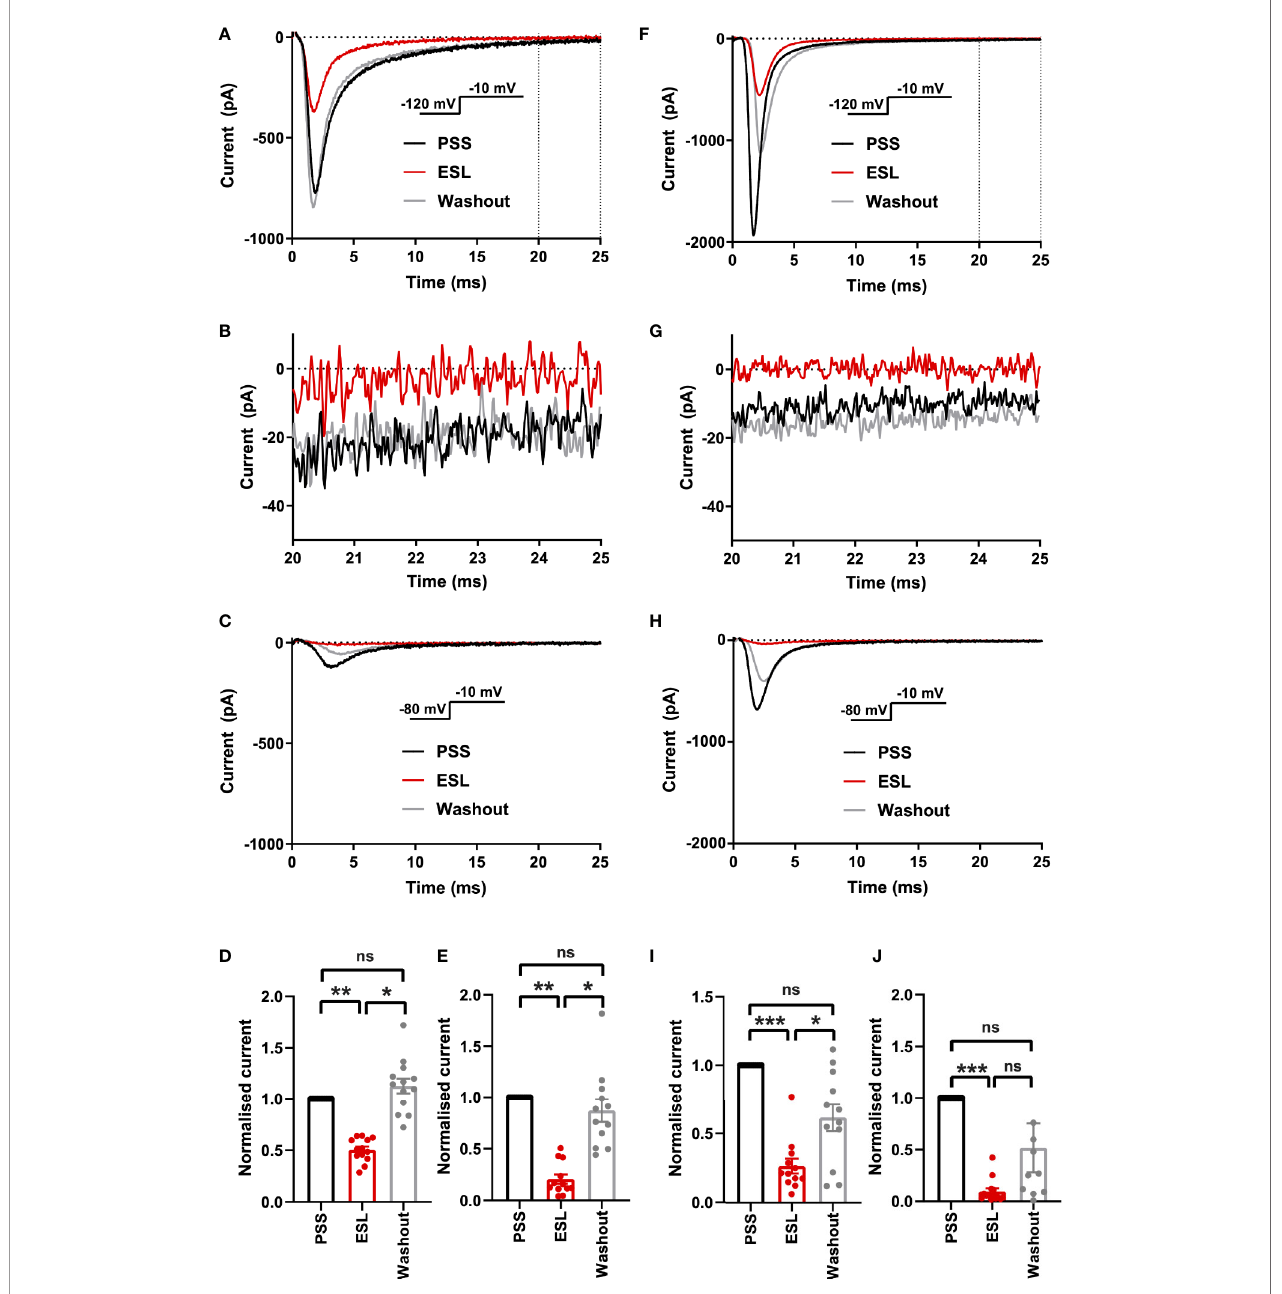
FIGURE 2 | Effect of eslicarbazepine acetate on Na v 1.5 currents. (A) Representative Na + currents in an MDA-MB-231 cell elicited by a depolarisation from -120 to -10 mV in physiological saline solution (PSS; black), eslicarbazepine acetate (ESL; 300 m M; red) and after washout (grey). Dotted vertical lines de fi ne the time period magni fi ed in (B) . (B) Representative persistent Na + currents in an MDA-MB-231 cell elicited by a depolarisation from -120 to -10 mV. (C) Representative Na + currents in an MDA-MB-231 cell elicited by a depolarisation from -80 to -10 mV. (D) Normalized Na + currents in MDA-MB-231 cells elicited by a depolarisation from -120 to -10 mV. (E) Normalized Na + currents in MDA-MB-231 cells elicited by a depolarisation from -80 to -10 mV. (F) Representative Na + currents in a HEK-Na v 1.5 cell elicited by a depolarisation from -120 to -10 mV in PSS (black), ESL (300 m M; red) and after washout (grey). Dotted vertical lines de fi ne the time period magni fi ed in (G) . (G) Representative persistent Na + currents in a HEK-Na v 1.5 cell elicited by a depolarisation from -120 to -10 mV. (H) Representative Na + currents in a HEK- Na v 1.5 cell elicited by a depolarisation from -80 to -10 mV. (I) Normalized Na + currents in HEK-Na v 1.5 cells elicited by a depolarisation from -120 to -10 mV. (J) Normalized Na + currents in HEK-Na v 1.5 cells elicited by a depolarisation from -80 to -10 mV. Results are mean + SEM. *P ≤ 0.05; **P ≤ 0.01; ***P ≤ 0.001; one- way ANOVA with Tukey tests (n = 12 – 14). NS, not signi fi